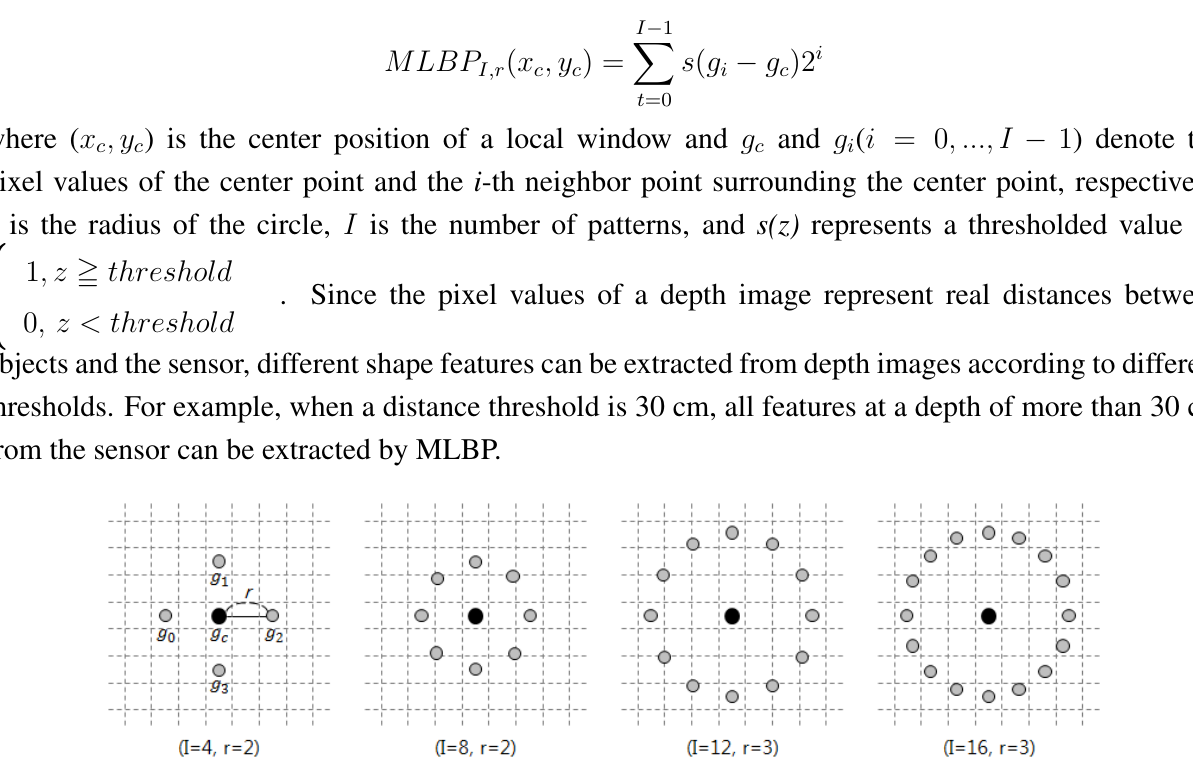
Figure 1. Modified local binary pattern with different I (the number of patterns) and r (the circle’s radius)